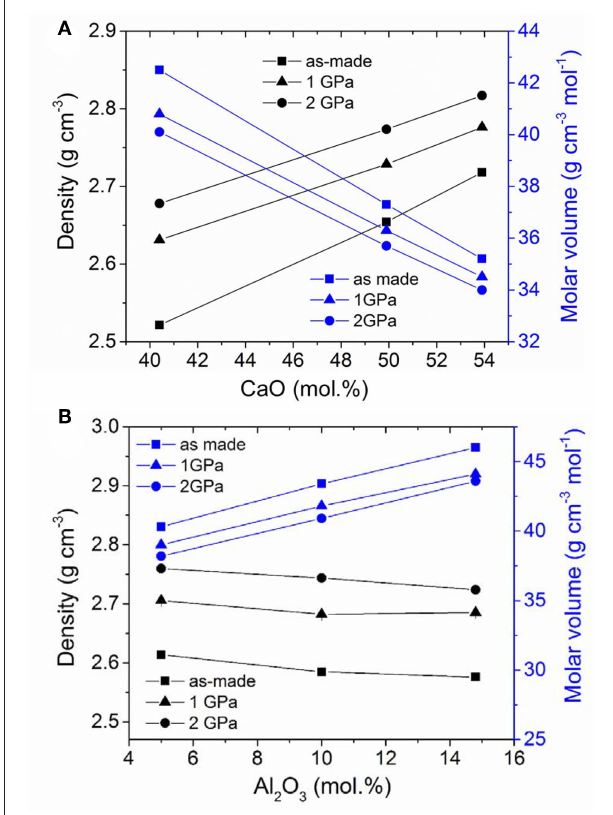
FIGURE 6 | Density and molar volume of as-prepared and hot compressed glasses as a function of the molar concentration of (A) CaO and (B) Al 2 O 3 in CaO-P 2 O 5 and CaO-Al 2 O 3 -P 2 O 5 glasses, respectively. The errors associated with the density values are smaller than the size of the symbols.